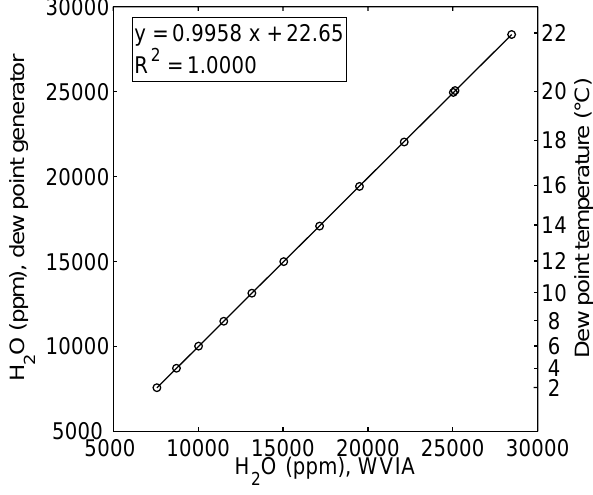
Fig. 8. Calibration of the water vapor mixing ratio with a dew point